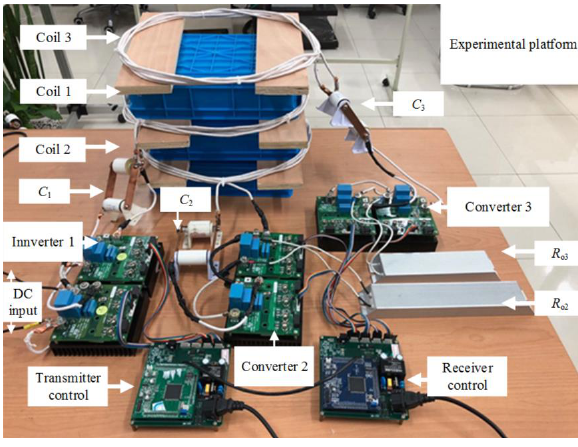
Figure 7. Experimental platform.